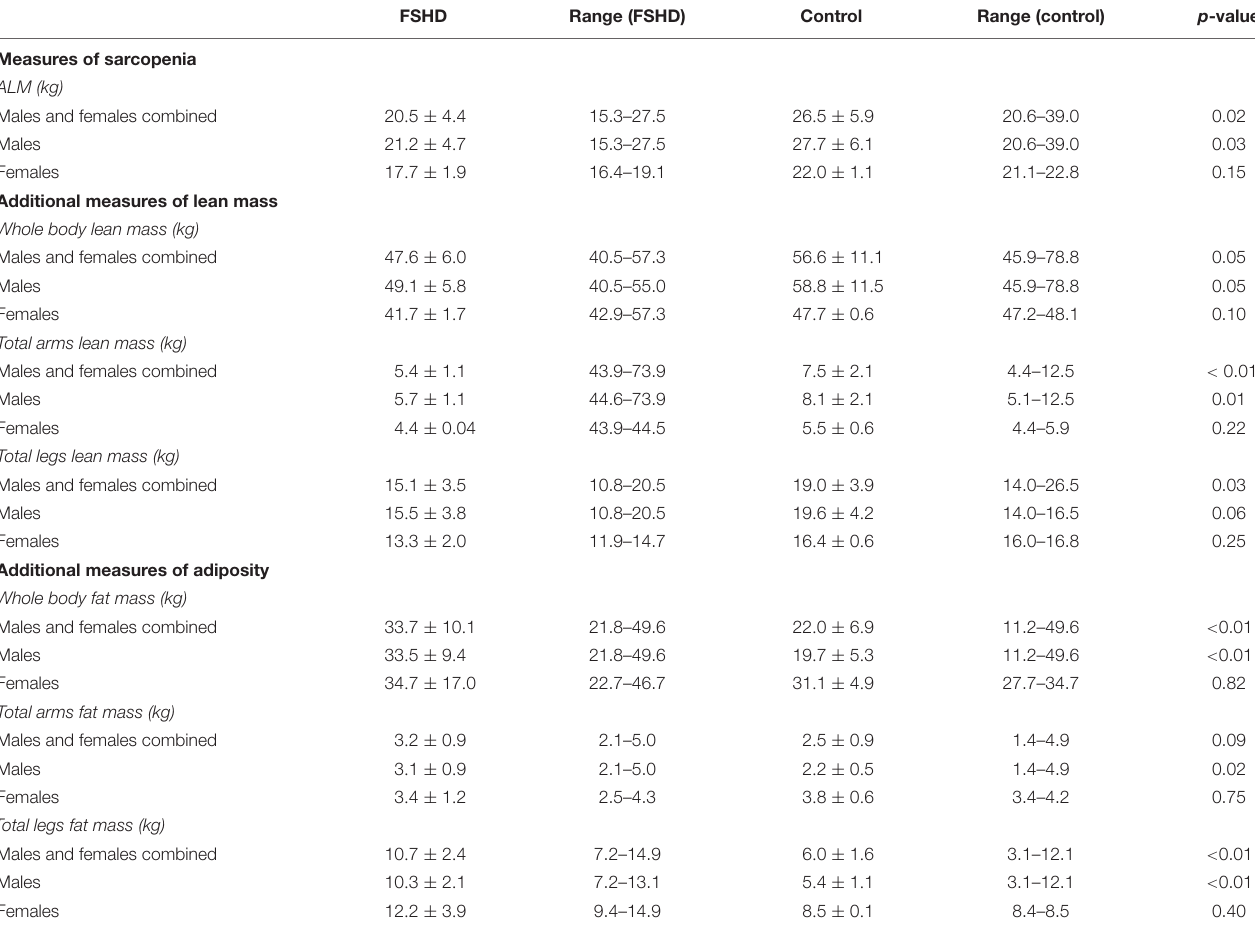
TABLE 2 | Measures of body composition. FSHD Range (FSHD) Control Range (control) p